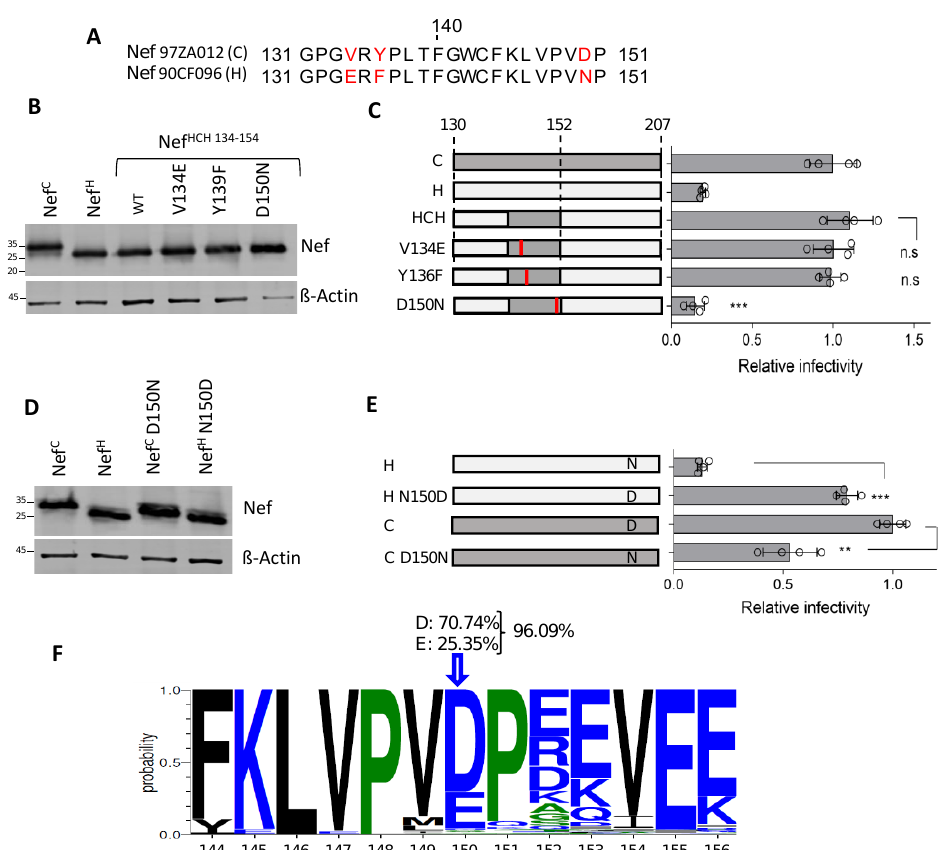
Figure 4. Conversion of Asn to Asp in position 150 fully restores the counteraction activity of Nef H . ( A ) Pairwise alignment of the 21 aa minimal sequence which transfers the SERINC5 counteracting activity from Nef H to Nef C , indicating the presence of three divergent residues (in red). ( B , C ): Within the minimal sequence rescuing the activity of Nef H , D150 is required for SERINC counteraction. ( D , E ): D150 is sufficient to restore the SERINC5 counteracting activity in Nef H . ( B , E ) show west- ern blots of lysates from virus producing cells for the detection of the indicated HA-tagged Nef. ( C , E ) show the infectivity of HIV-1 limited to a single cycle of replication produced in the presence of SERINC5 and the indicated Nef proteins, relative to the infectivity measured with Nef C . Bar graphs represent the mean relative infectivity. Mean ± s.d. (biological quadruplicates), unpaired two-tailed t -test, ** p < 0.01, *** p < 0.001 (GraphPad). ( F ): Sequence logo representing the conservation of